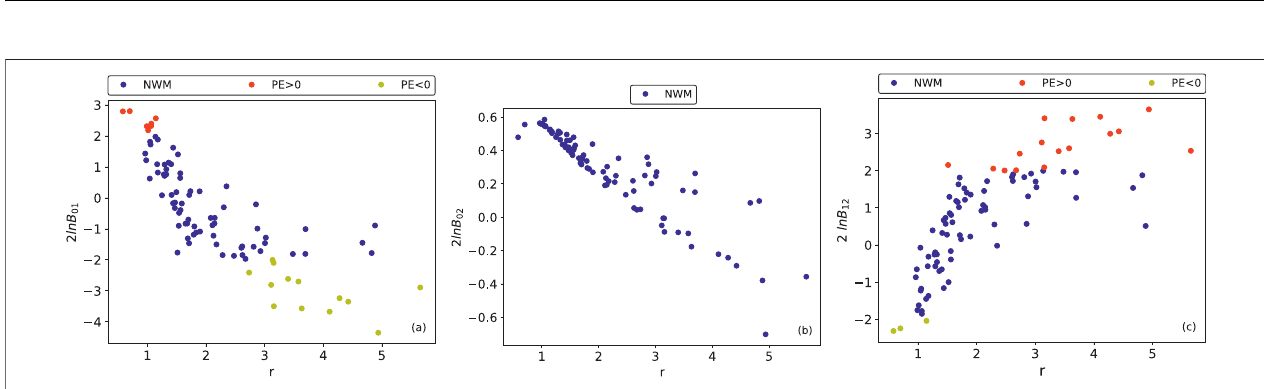
FIGURE 6 | Bayes factors in the one-to-one comparison between resonant absorption, phase mixing, and wave leakage mechanisms as a function of the observablesperiodanddampingtimewithuncertaintiesof10%foreach.Thedashedlinesindicate τ d = P .Thedifferentlevelsofevidenceareindicatedinthecolourbars. Not Worth a bare mention (NWM, yellow), Positive (PE, green/red), Strong (SE, blue/purple), Very strong (VSE, white/grey). Adapted from Montes-Solís and Arregui (2017).